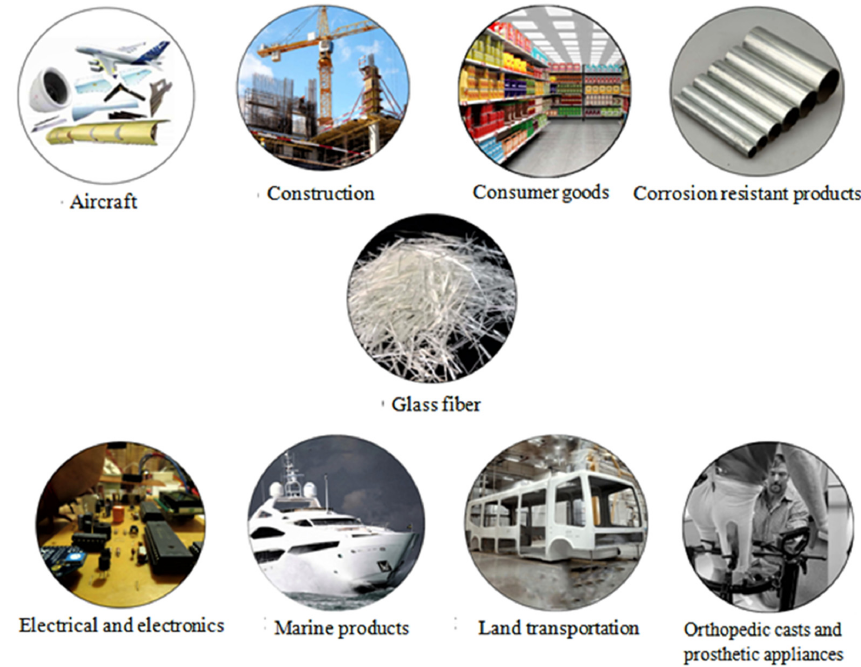
Figure 9. Glass fiber applications in various sectors.